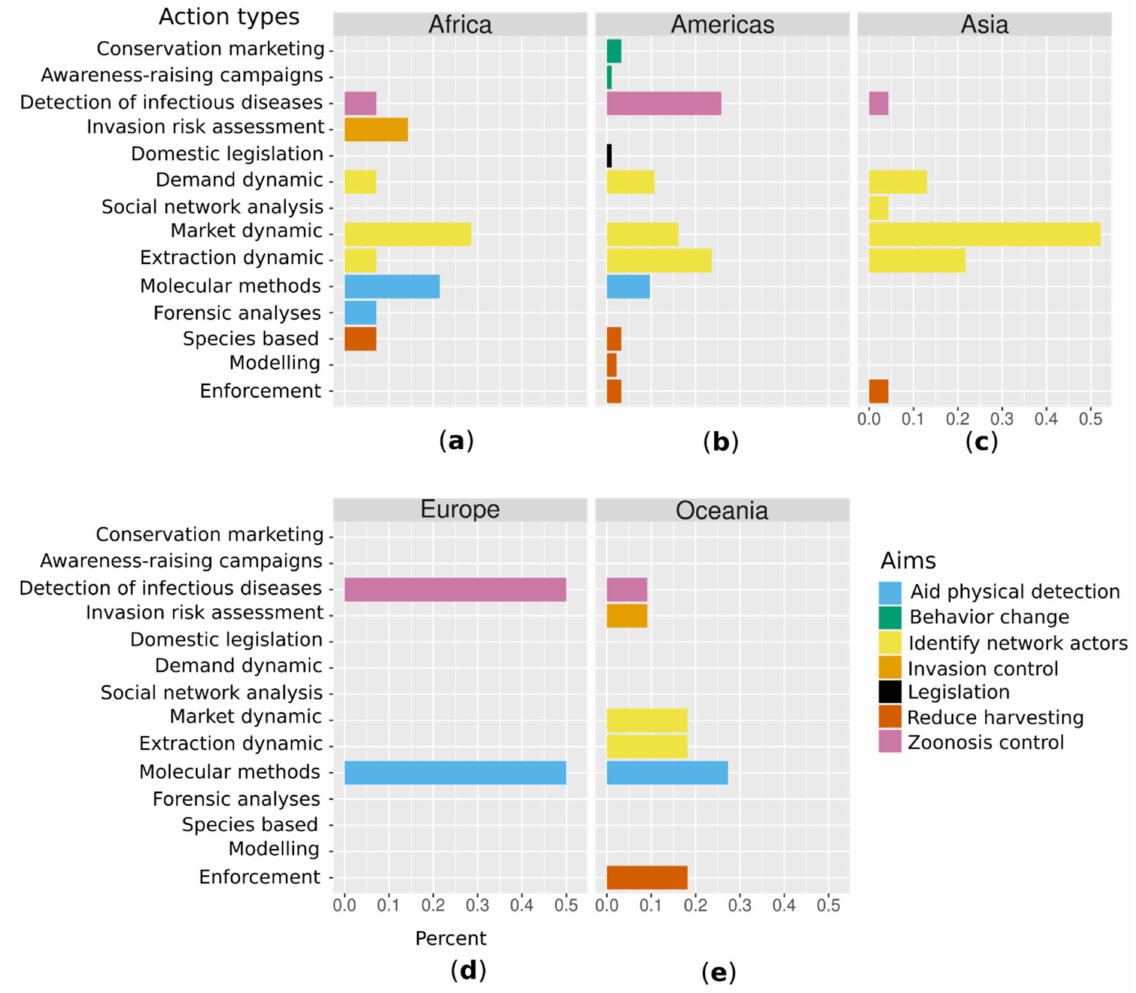
Figure 6. Action types used to tackle illegal parrot trade in in ( a ) Africa, ( b ) Americas, ( c ) Asia, ( d ) Europe, and ( e ) Oceania. Percentages of documents reporting each action type are shown. Actions are grouped by